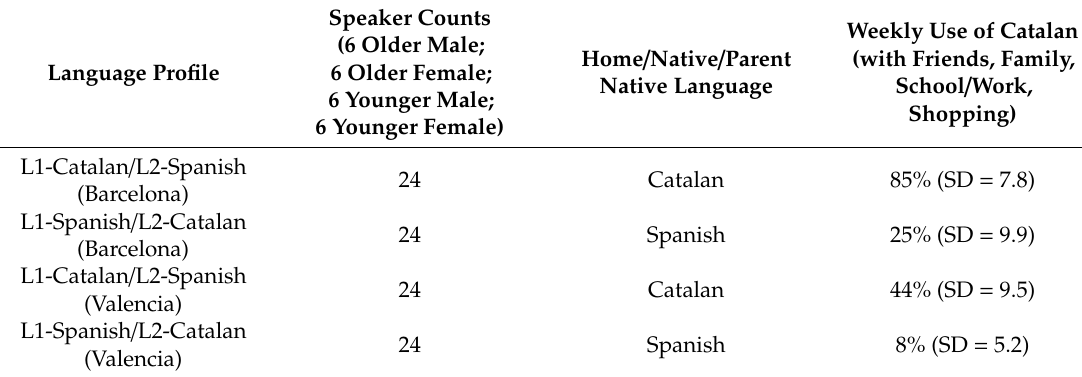
Table 1. Subject